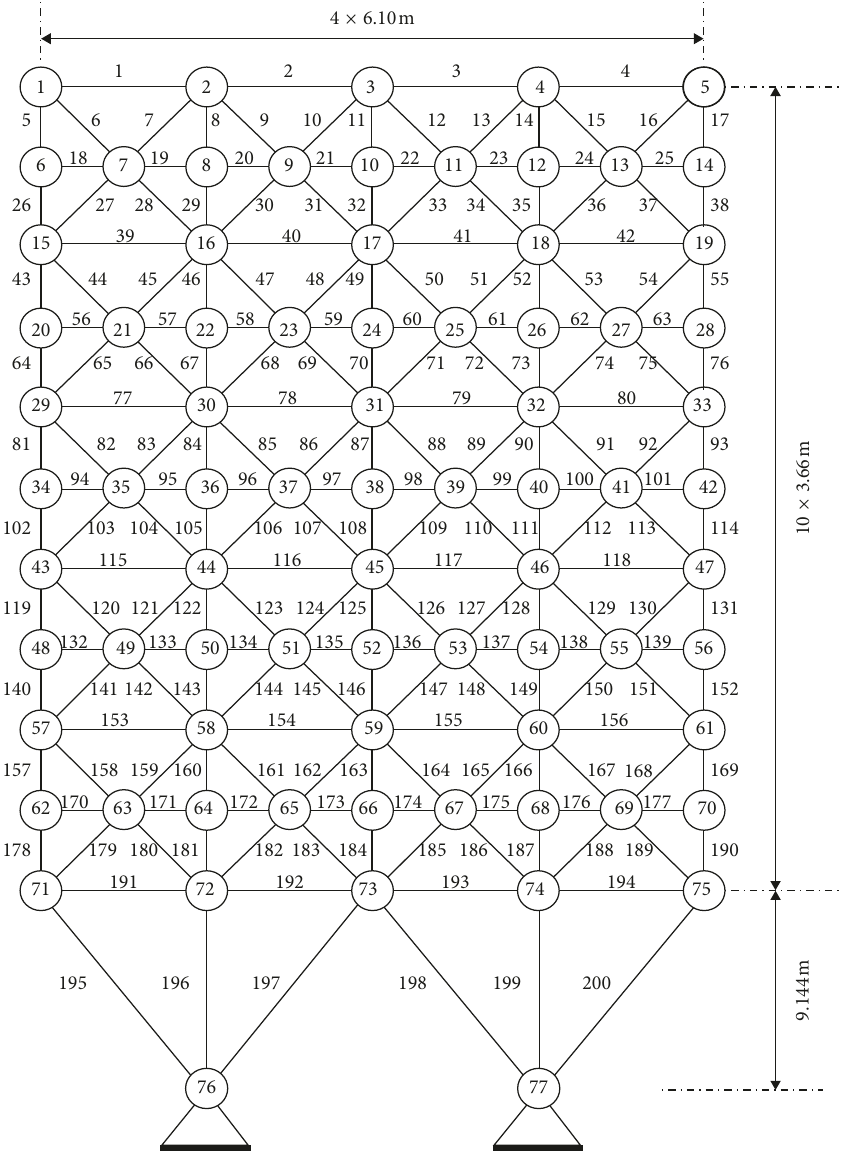
Figure 13: Schematic diagram of the 200bar plane truss